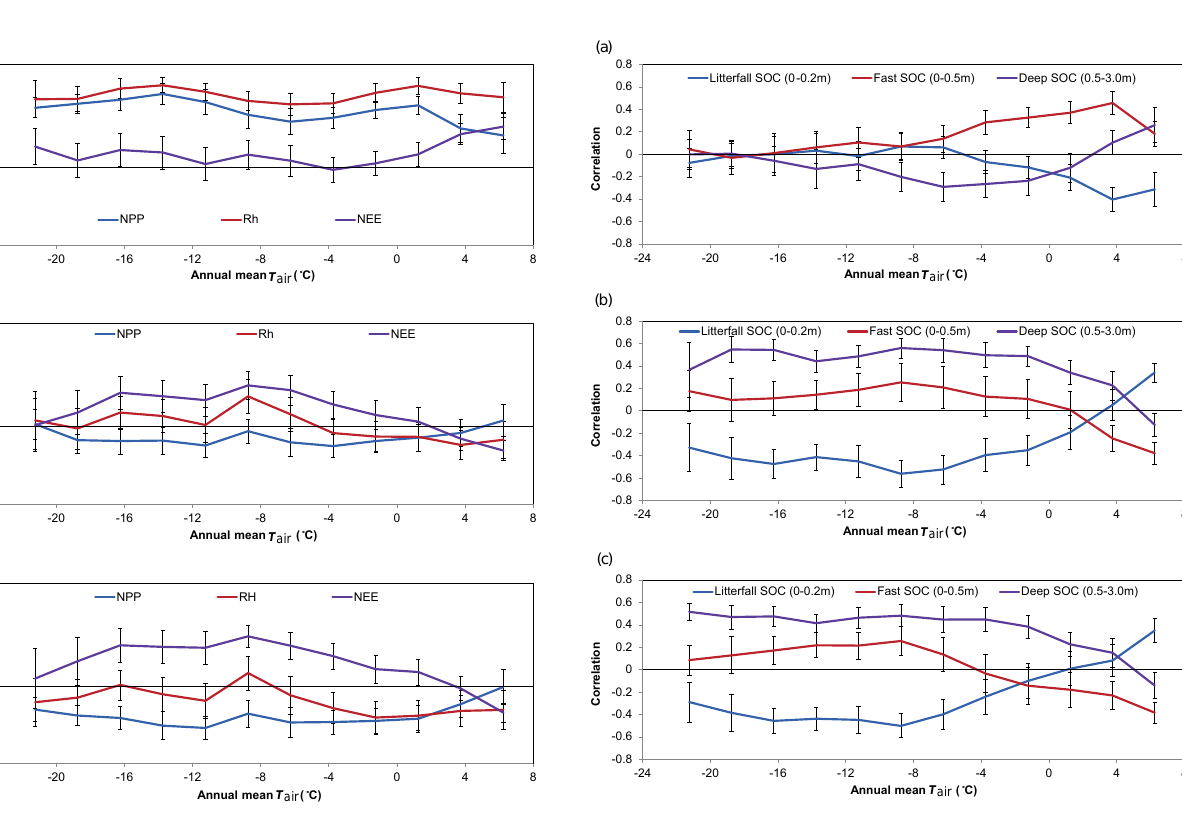
ally corresponded to increasing (decreasing) soil R h fraction